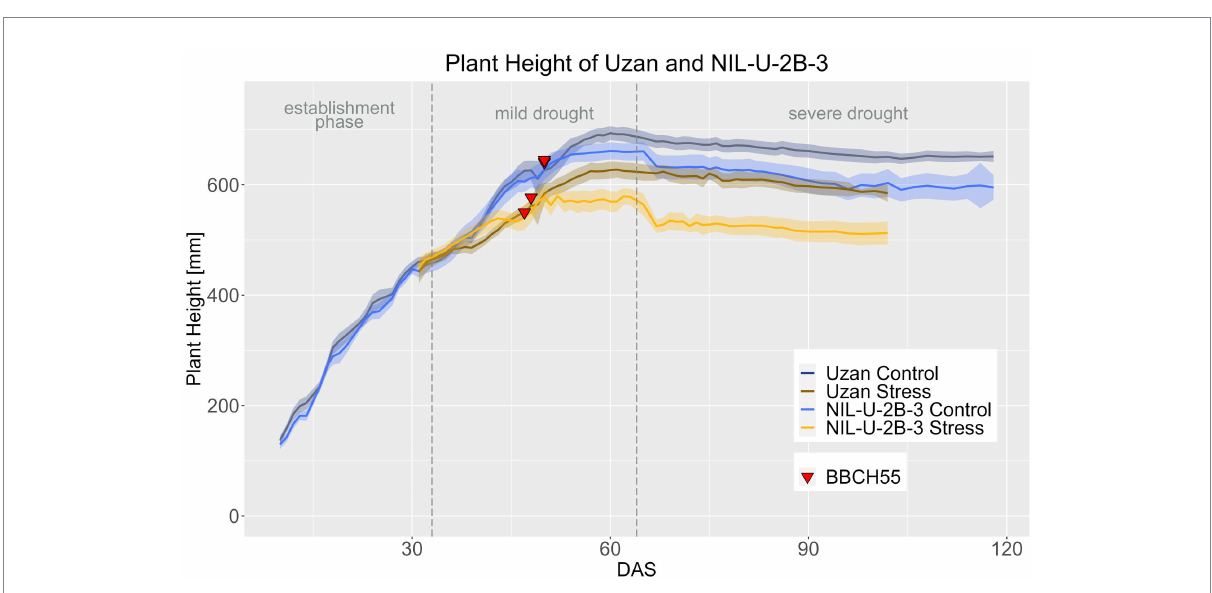
FIGURE 11 Plant height of Uzan and NIL-U-2B-3 based on calculated BLUEs values. DAS, days after sowing; BBCH55, heading day. The last DAS for each genotype was chosen for the DAS where the last time 60% of the plants were imaged (as mature plants were taken off subsequently). The shadows describe the confidence interval; as long as the shadows of the individual lines do not overlap, the significance level of a = 0.05 is not reached and therefore a significant difference